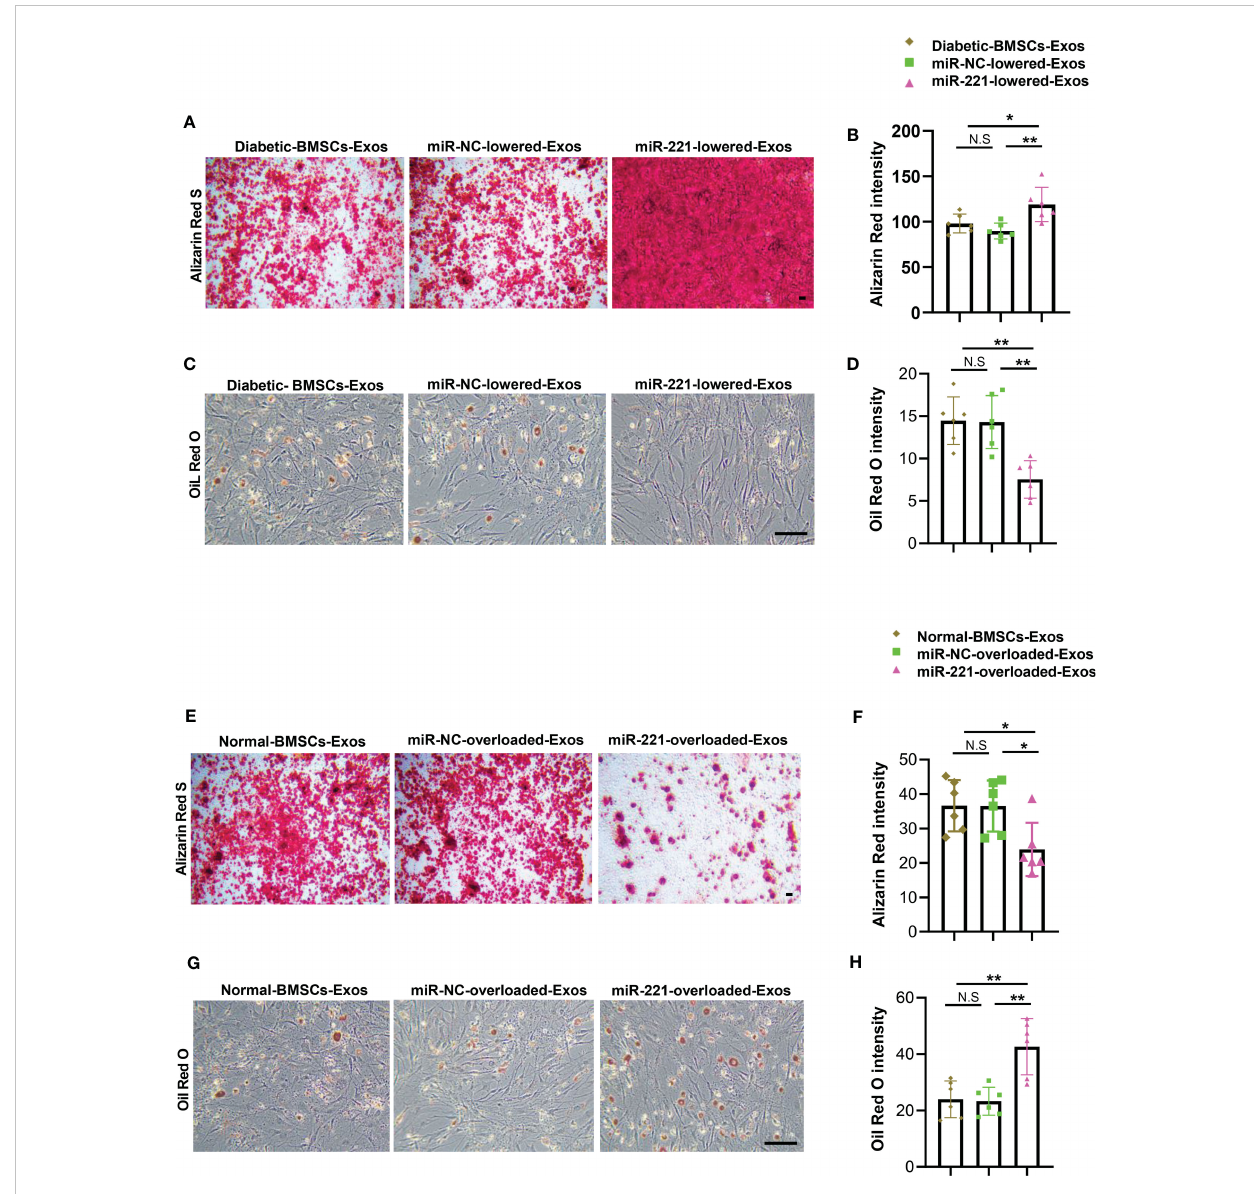
FIGURE 6 MiR-221 lowered diabetic-BMSCs-Exos regains the ability of enhancing osteogenesis and suppressing adipogenesis. (A-D) Transfected miR-221 inhibitor in BMSCs of diabetic mice using lipofectamine ™ 2000 ragent for 72h, isolated miR-221-lowered-exosomes, then add to BMSCs which cultured in osteogenic and adipogenic medium. (A-D) miR-221-lowered-exosomes were added to BMSCs, then cultured BMSCs in osteogenic induction medium for 21 days, and BMSCs in osteogenic induction medium for 14 days. (A) Representative images of matrix mineralized ash, Scale bar: 100 m M; (B) quanti fi cation of Alizarin Red S staining; (C, D) Representative images of lipid droplet, Scale bar: 100 m M and quanti fi cation of Oil Red O staining. (E-H) Overexpress miR-221 in normal BMSC, collect miR-221-overloaded-Exos and add to BMSCs which cultured in osteogenic and adipogenic medium for 21 days and 14 days, respectively. (E) Representative images of matrix mineralized ash, Scale bar: 100 m M; (F) quanti fi cation of Alizarin Red S staining; (G, H) Representative images of lipid droplet, Scale bar: 100 m M and quanti fi cation of Oil Red O staining. The data is shown as the mean ± SD. * P <0.05, ** P <0.01 (ANOVA). NS, not signi fi